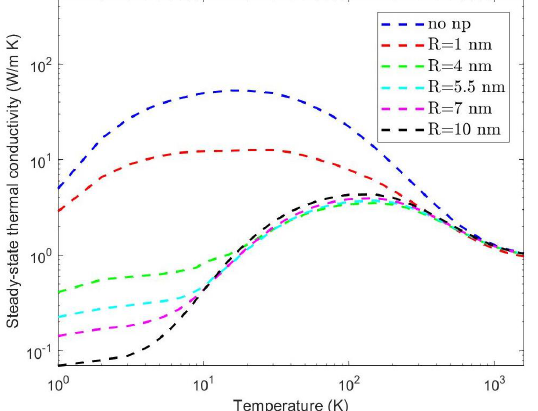
Figure 8. Steady-state thermal conductivity versus temperature, for fnp = 2% and various values of the nanoparticle radius, no np labels the case in which there are no nanoparticles.